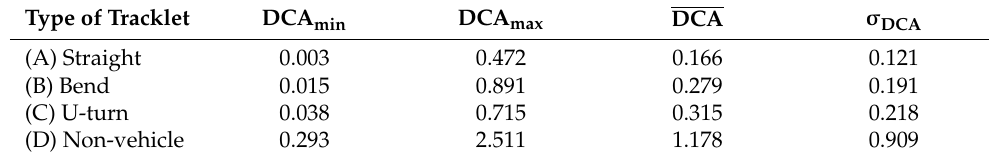
Figure 5. Calculation of the directional change angle. P 1 , P 2 , P 3 , and P 4 are points on the tracklet. β 2 and β 3 are two directional change angles formed by P 1 , P 2 , P 3 , and P 4 . Table 1. Statistics of DCAs for each tracklet